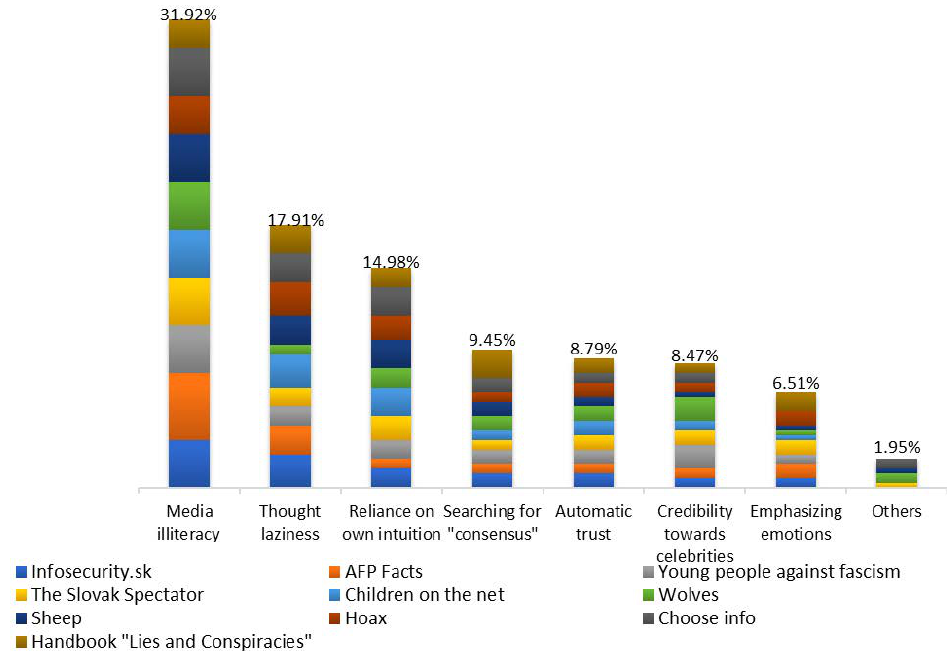
31.92% Figure 1. Research of risk factors of (false) resilience to media manipulation elements (n =